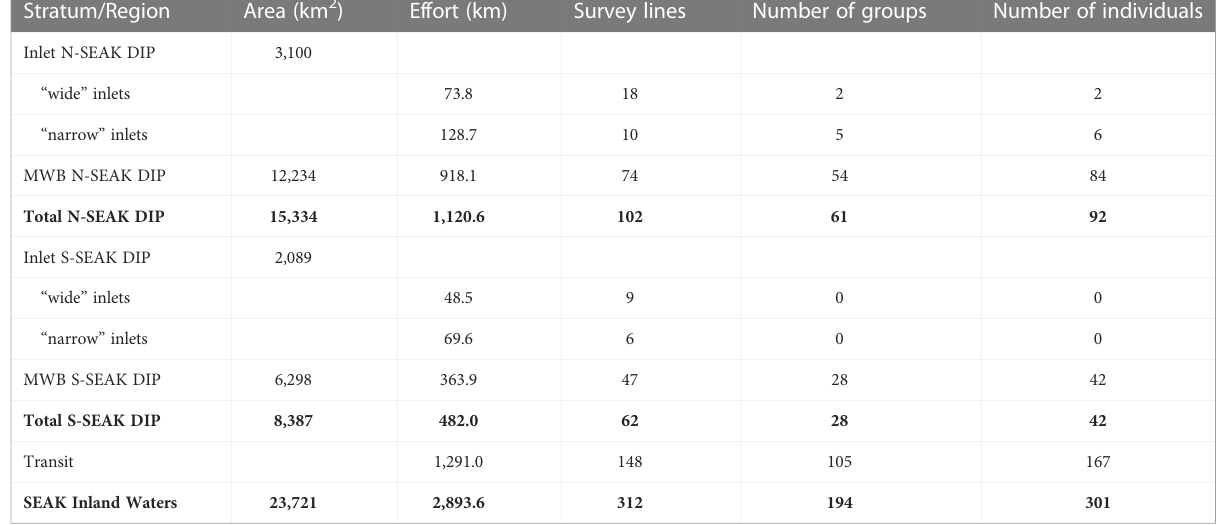
TABLE 1 Sampled area, survey effort and number of groups and individuals seen during the 2019 harbor porpoise survey in Southeast Alaska inland waters. Rows in bold represent totals across the N-SEAK DIP, the S_SEAK DIP and the whole of SEAK Inland Waters.